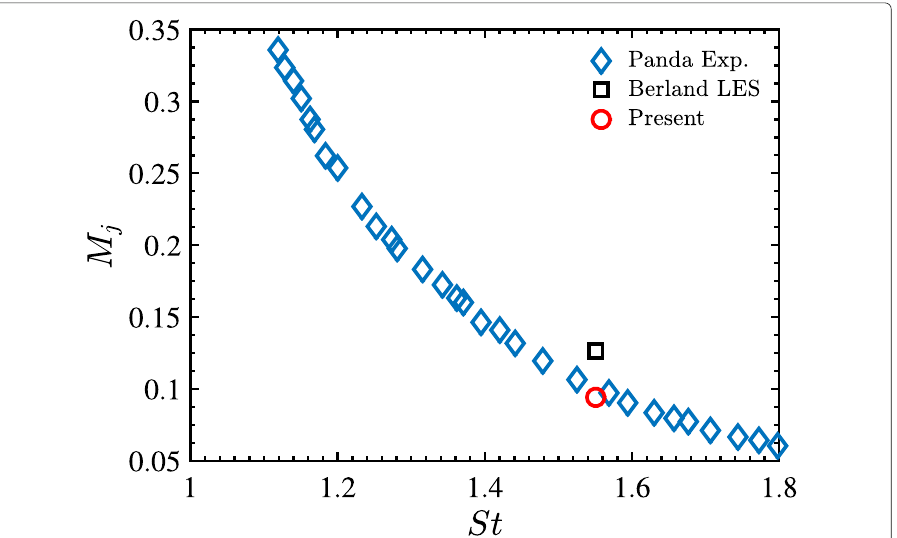
points within the boundary layer, 70 points inside the jet height. The constant time step (cid:6) t = 2.5 × 10 − 3 is implemented. The non-dimensional time for the whole computation is 360, and only the last 210 is outputted for analysis. Three Titan V GPUs are utilized for computation, and the execution time for the simulation is only about 41 hours.